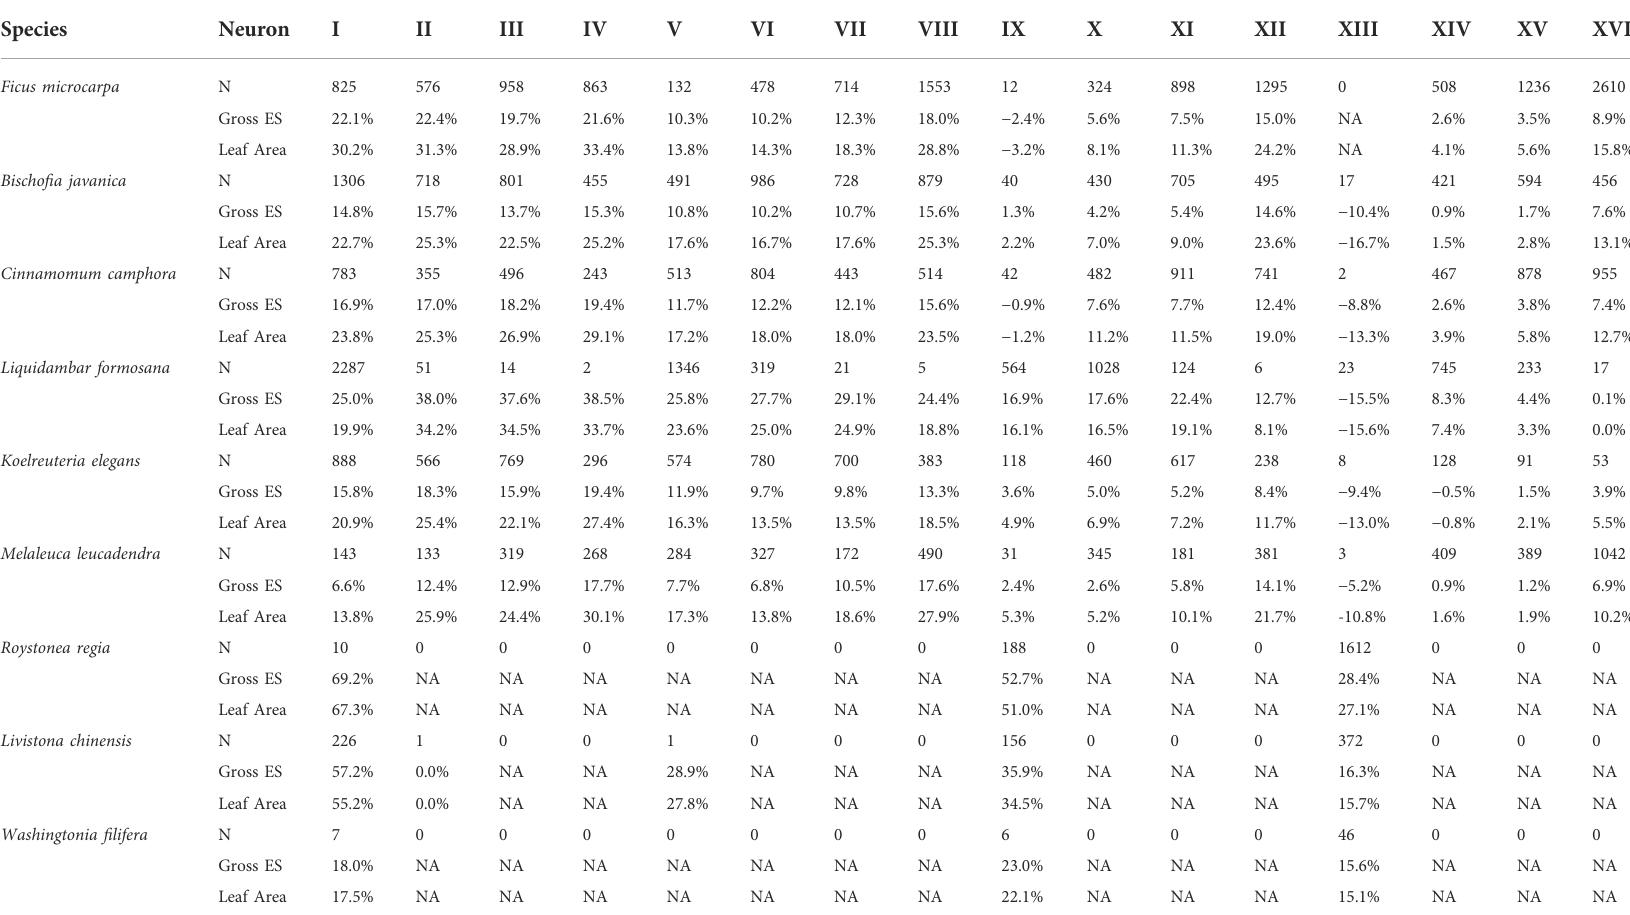
TABLE 2 Examples of the percentage loss of gross ES and leaf area to the estimated highest values at DBH for dominant species clustered in each neuron with the number of individual trees (N).